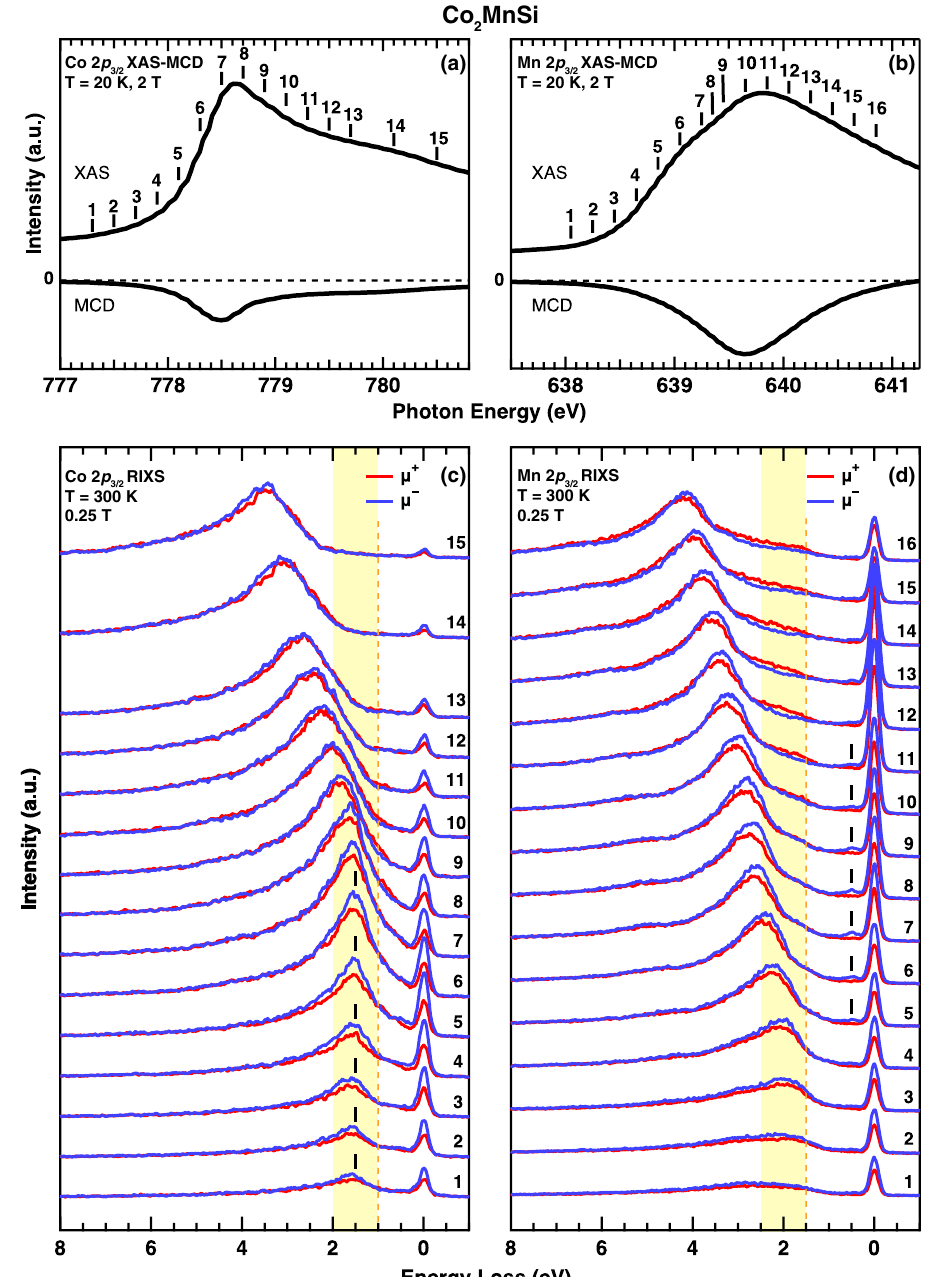
Figure 2. ( a , b ) XAS and XAS-MCD spectra of Co 2 MnSi obtained at the Co and Mn 2 p 3 / 2 edges. ( c , d ) Photon energy dependence of the Co and Mn 2 p 3 / 2 RIXS spectra for Co 2 MnSi obtained by µ + and µ − configurations recorded at the excitation photon energies indicated by the numbers above the vertical bars on the XAS spectra. The hatched regions are guides to the eye for showing the evolution of the RIXS structures, and the vertical dashed lines indicate the threshold